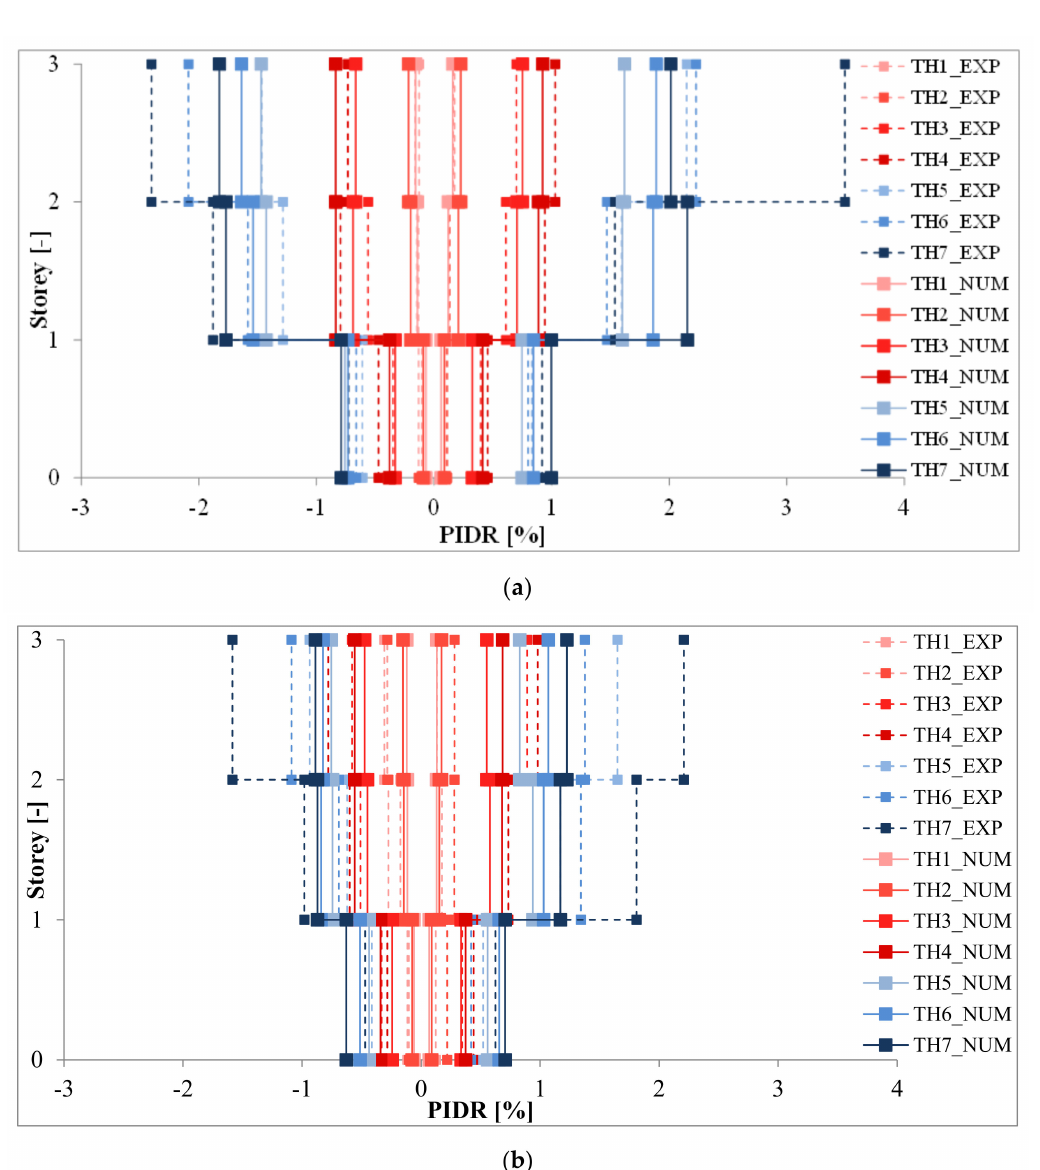
Figure 8. Comparison between experimental and numerical peak inter-story drift ratio (PIDR) [42]. ( a ) Type 1, ( b ) Type